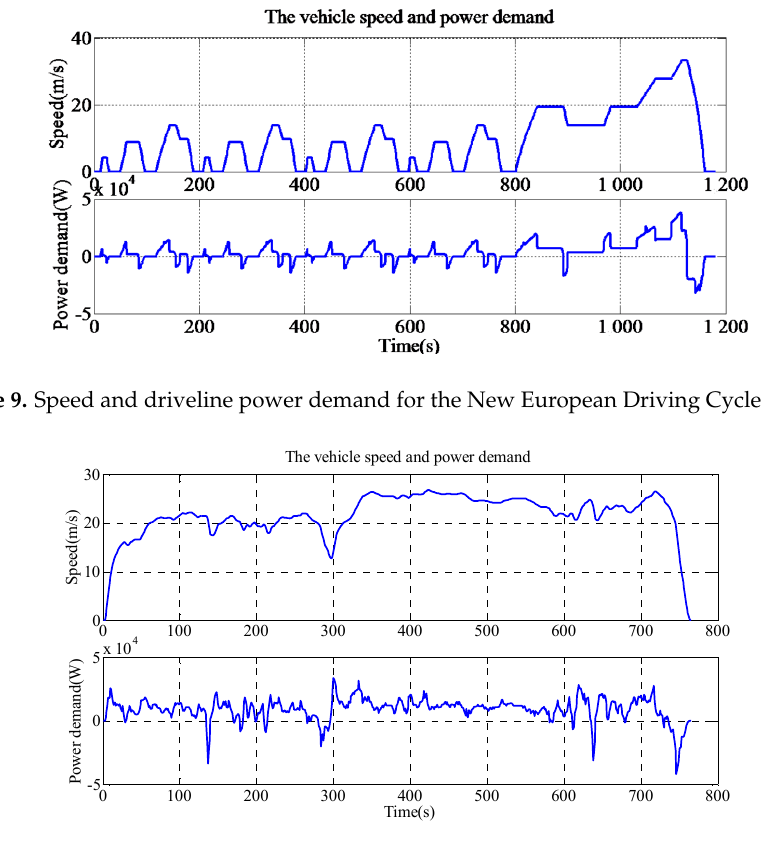
Figure 10. Speed and driveline power demand for the Highway Fuel Economy Driving Schedule (HWFET).